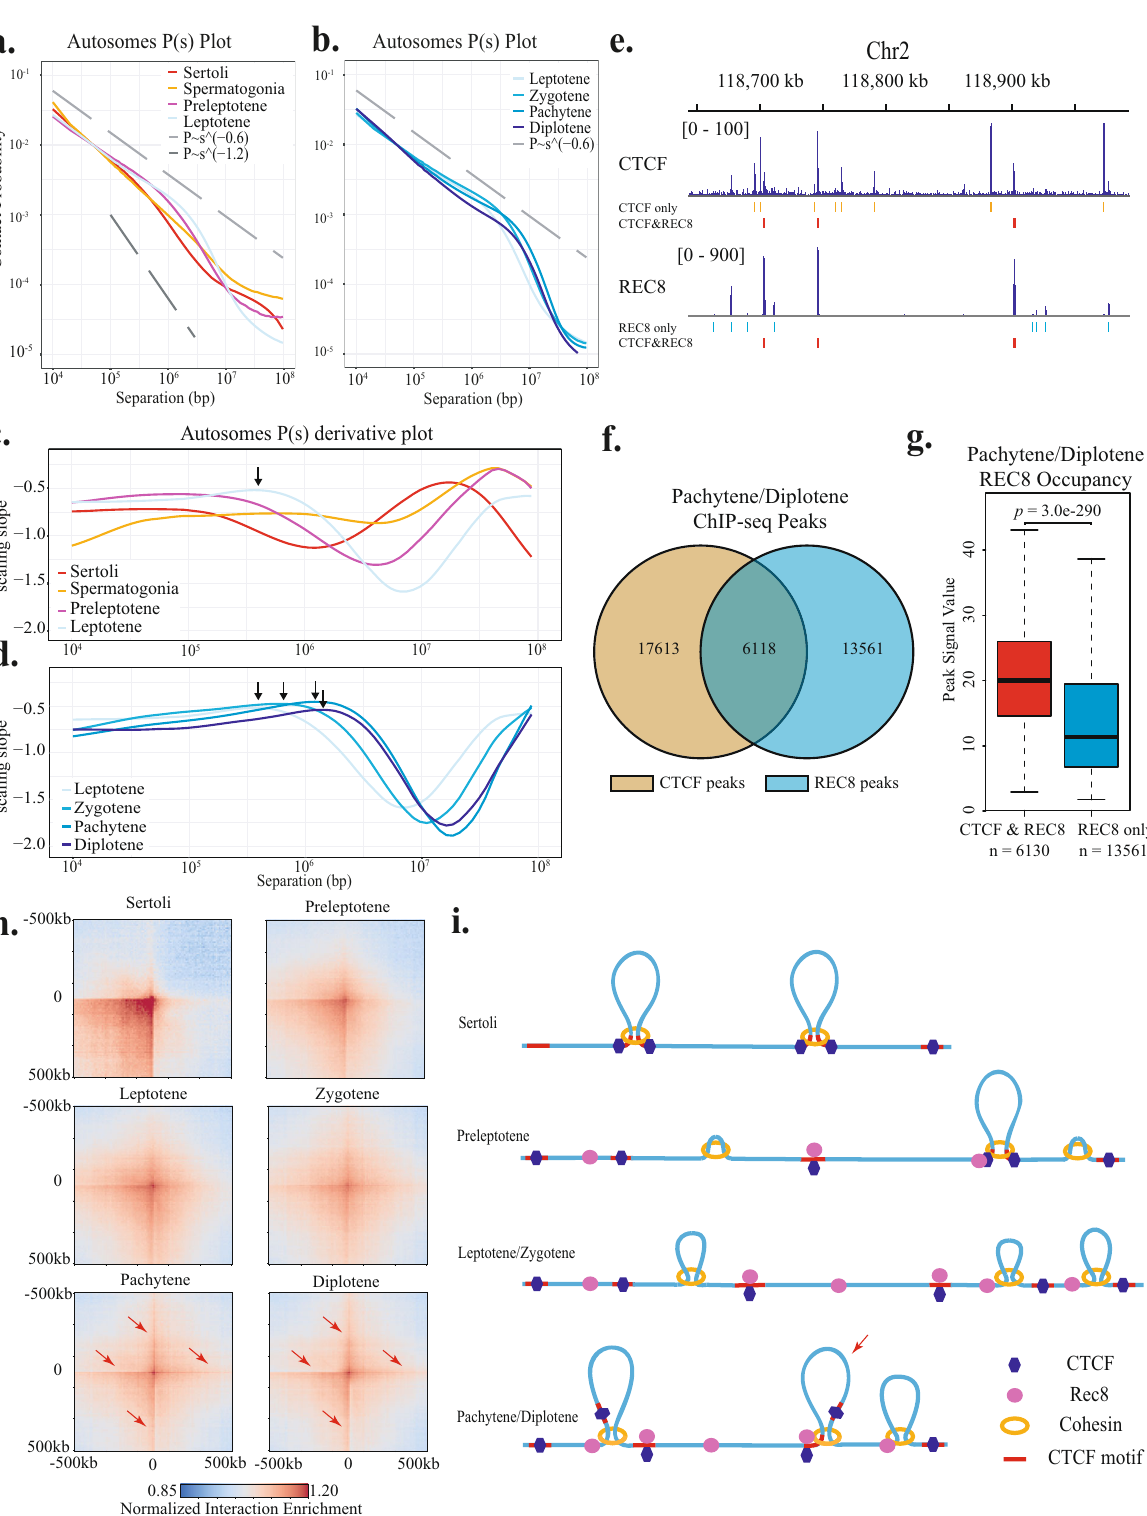
loops are tethered to the meiotic chromosome axis. Cohesin subunit REC8 is a major structural component of the meiotic chromosome axis. In pre-meiotic cells, REC8 already starts to assemble on chromosomes, leading to the formation of short stretches of axial elements 55 . Previously published ChIP-Seq data revealed a large number of prominent REC8 peaks in the mixed population of mouse P/D spermatocytes 34 . By comparing